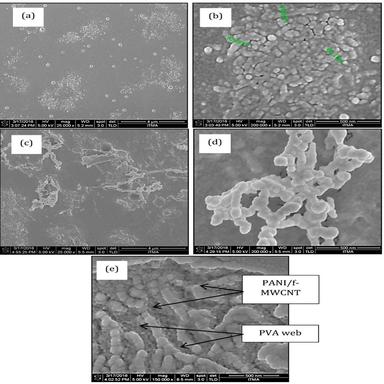
FESEM micrograph of 6 pph of functionalized CNT in the nanocomposite film for (a) unirradiated (mag. 100k x), (b) unirradiated (mag. 200k x), (c) irradiated at 50 kGy (mag. 100k x), (d) irradiated at 50 kGy (mag.200k x) and (e) cross section of the film irradiated at 50 kGy (mag. 150k x).